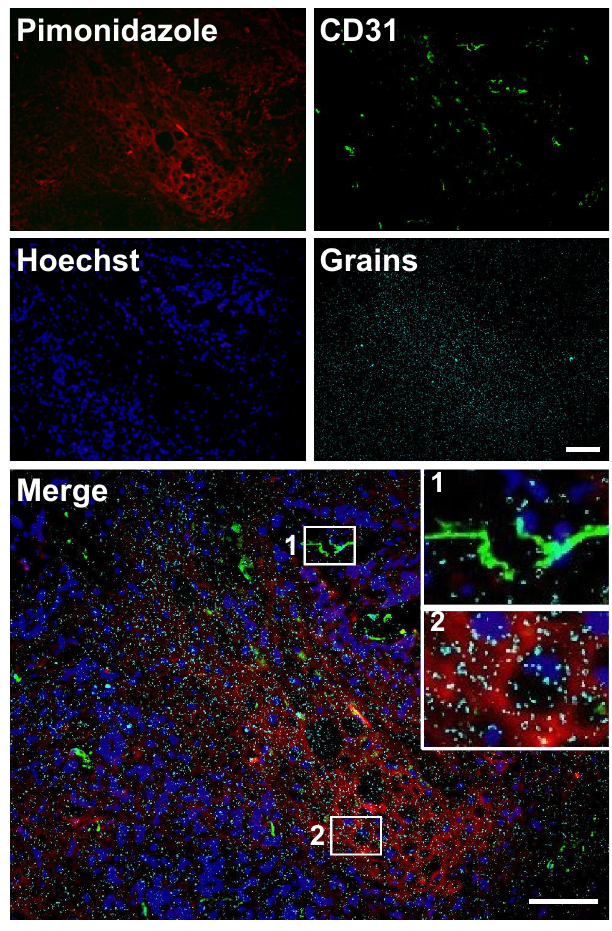
Figure 3. Micro-autoradiography of 18 F-FDG combined with immunohistochemistry. Merged image shows pimonidazole (red), CD31 (green), nuclei (blue), and grains (cyan) in the same view of the A431 cell-derived tumor section. Insets show a magnified view of the region demarcated by a white square in each panel. Bars: 100